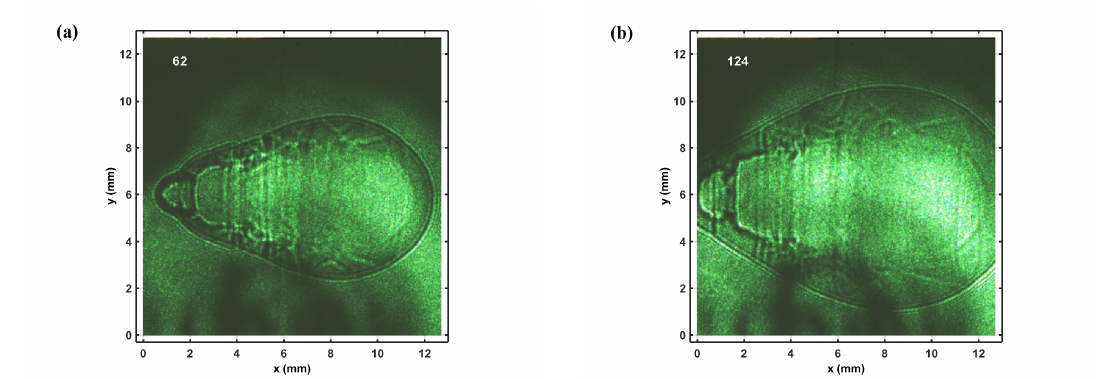
Figure 10. Shadowgraphs of optical breakdown in laboratory air. The laser beam propagates from the right, images are captured using a second, imaging laser. The “bubble” on the laser side indicates absorption of laser radiation. Time delay: ( a ) 1.5 µ s, image 62. ( b ) 3 µ s, image